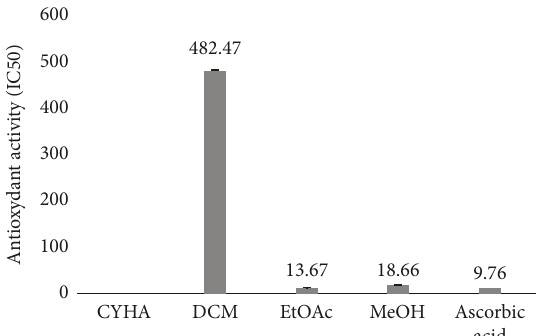
Figure 2: Antioxidant activity (IC50mg/L) of M. mabokeensis Aubr´ev bark extracts by DPPH assay. CYHA: cyclohexane; DCM: dichloromethane; EtOAc: ethyl acetate; MeOH: